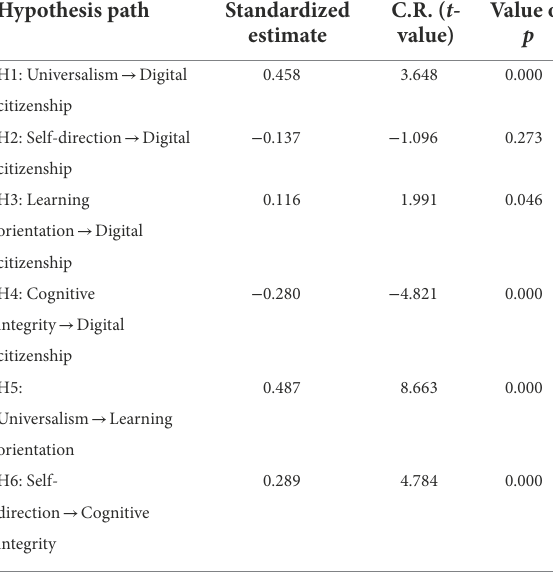
TABLE 4 The results of the structural model. Hypothesis